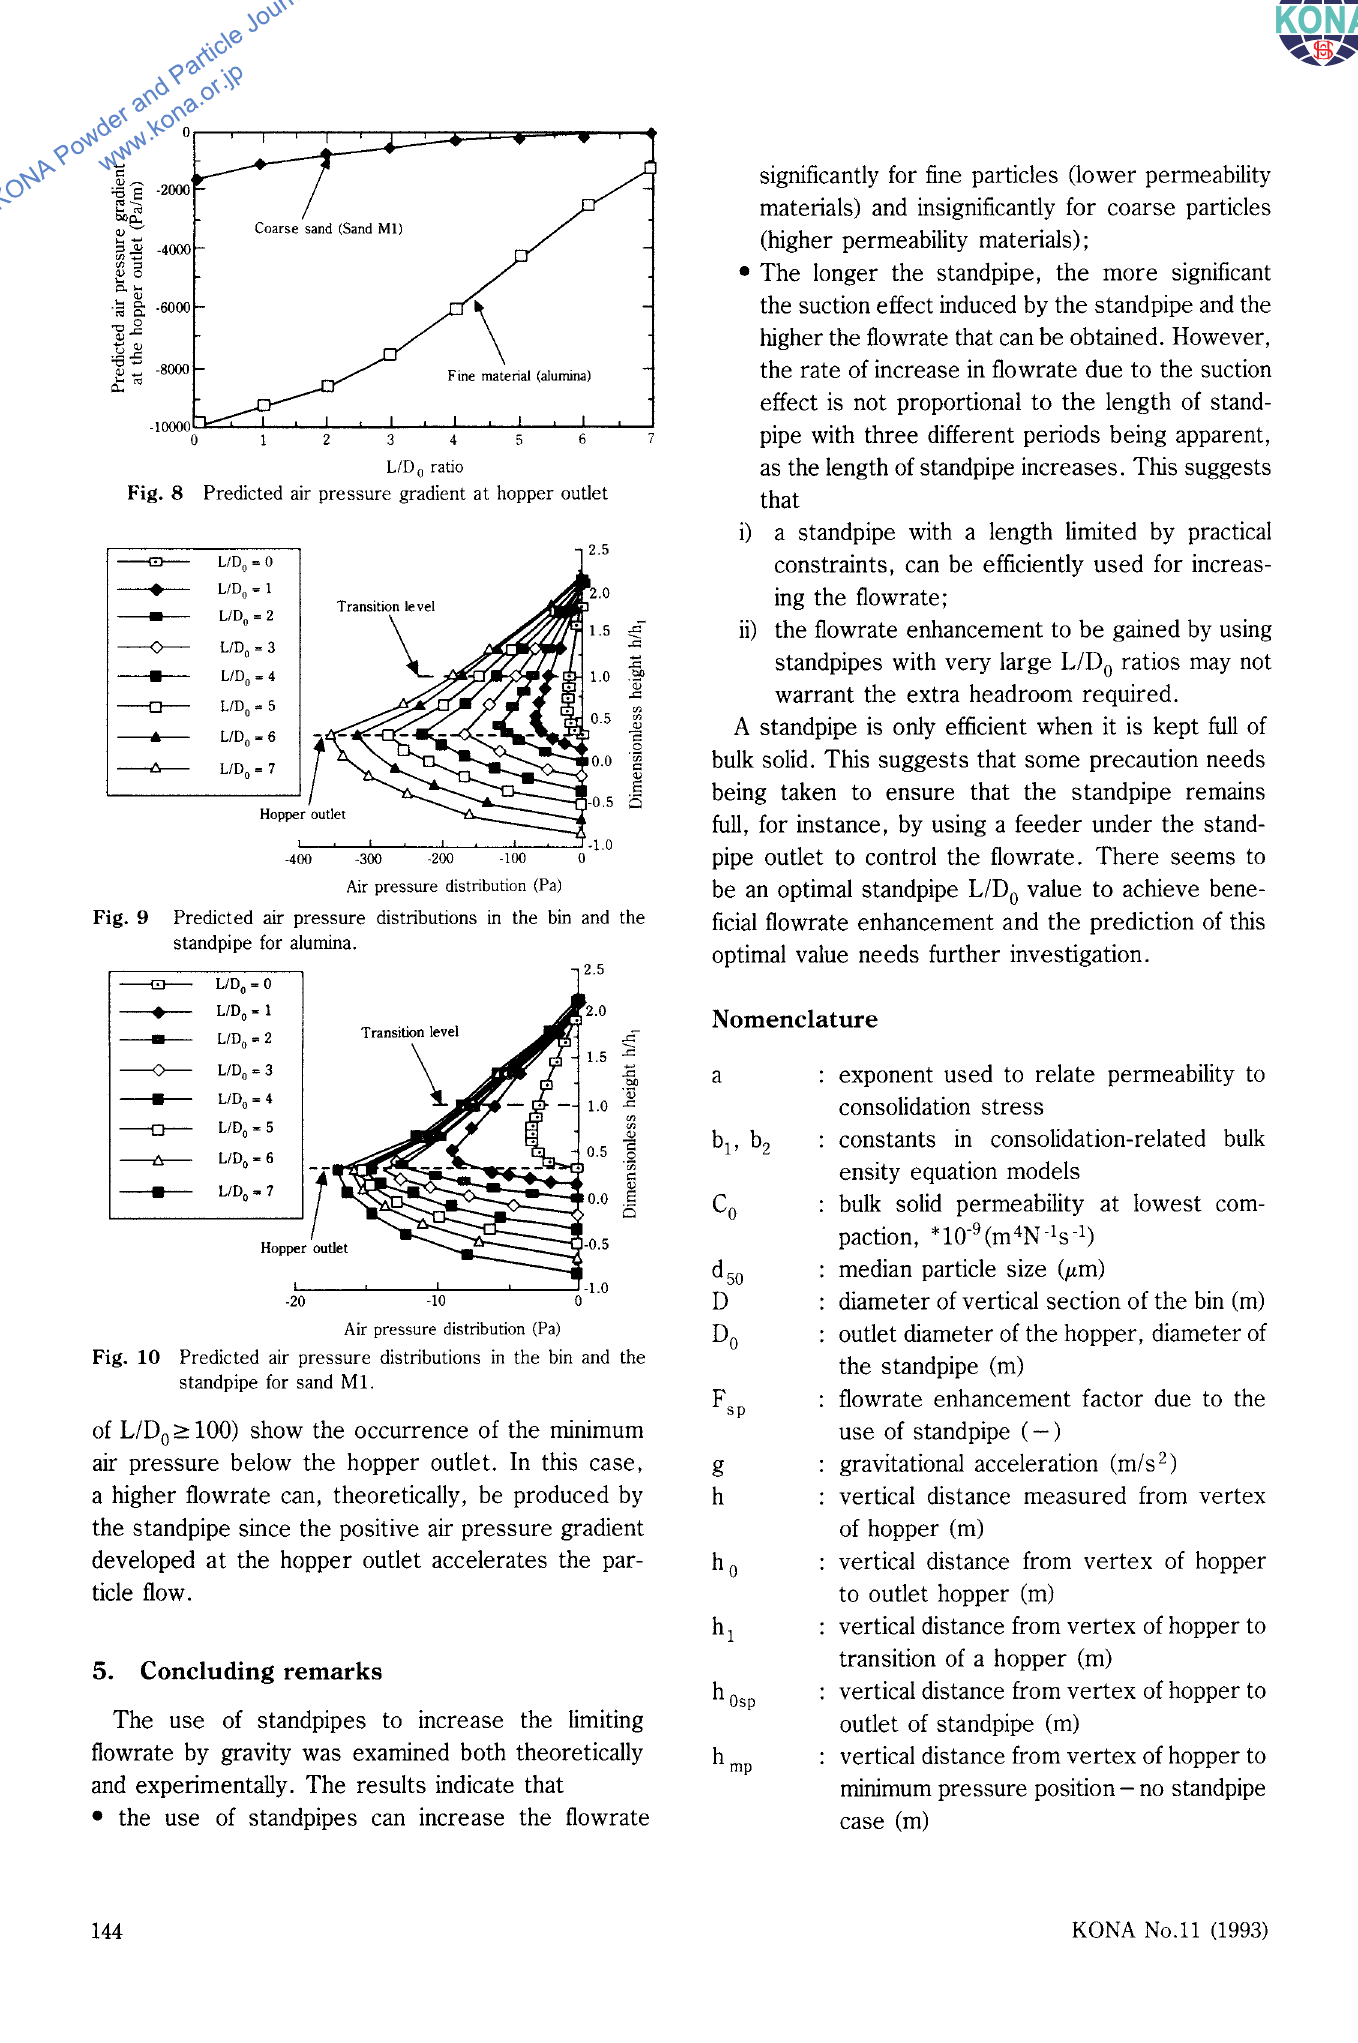
Air pressure distribution (Pa) Fig. 9 Predicted air pressure distributions in the bin and the standpipe for alumina.